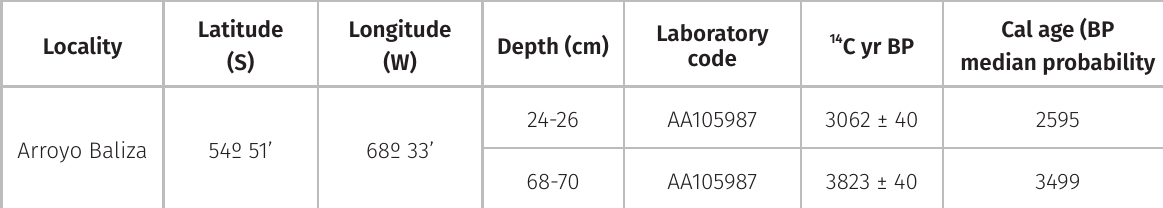
Table I. Radiocarbon and calibrated ages from Arroyo Baliza section (from Candel et al. 2017). Latitude Longitude Cal age (BP Laboratory 14 C yr BP Locality Depth (cm) code (S) (W) median probability